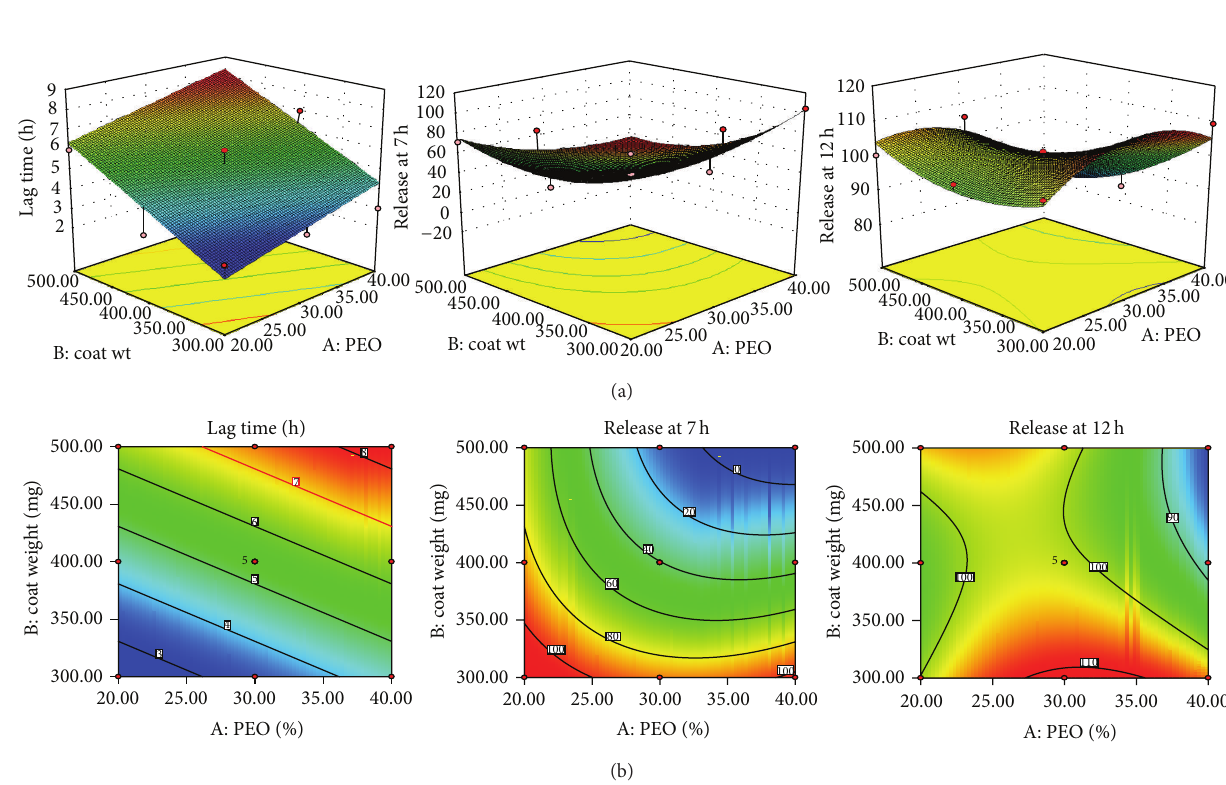
Figure 6: (a) Response plot and (b) contour plots for the effect of PEO % and coat weight on lag time and drug release.